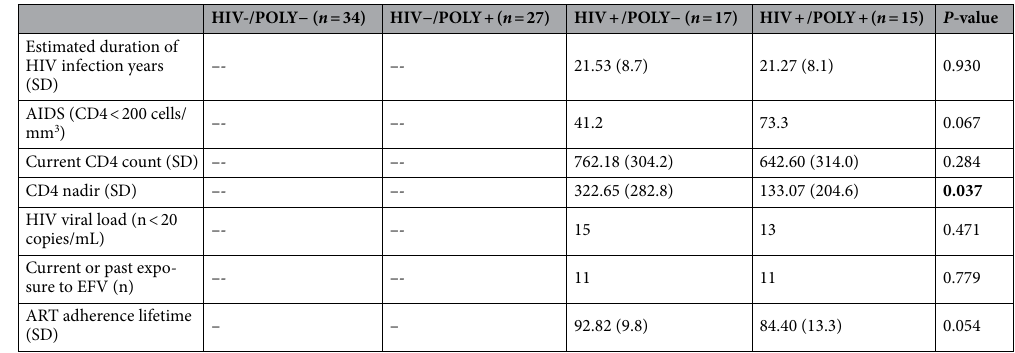
Table 2. Clinical variables across groups. Statistics are reported as in Table 1. SD = standard deviation. Significant values are in [bold], p <